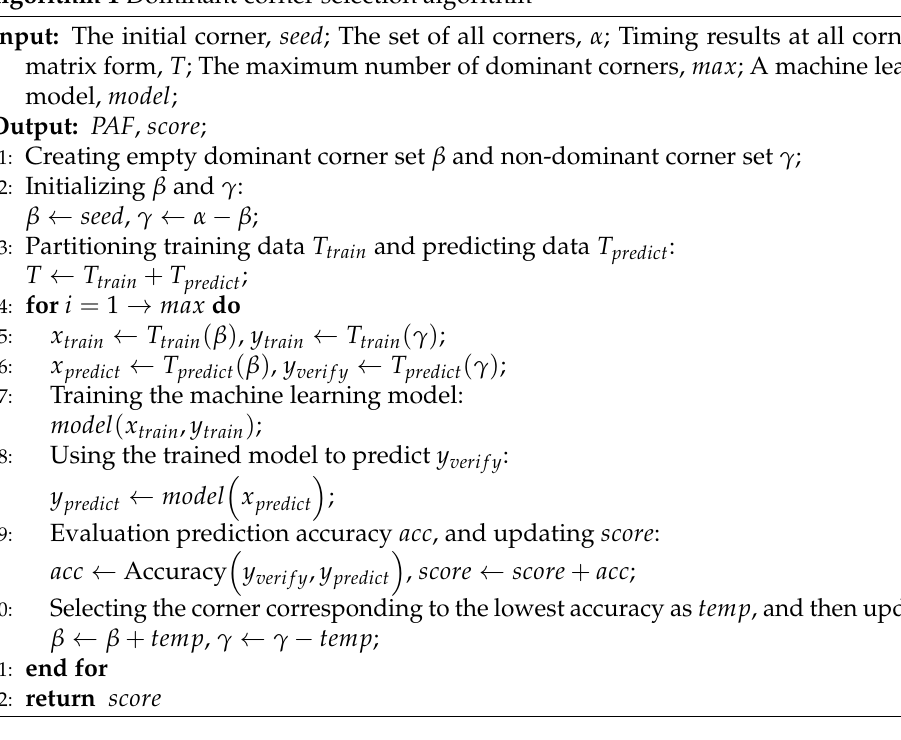
Algorithm 1 Dominant corner selection algorithm